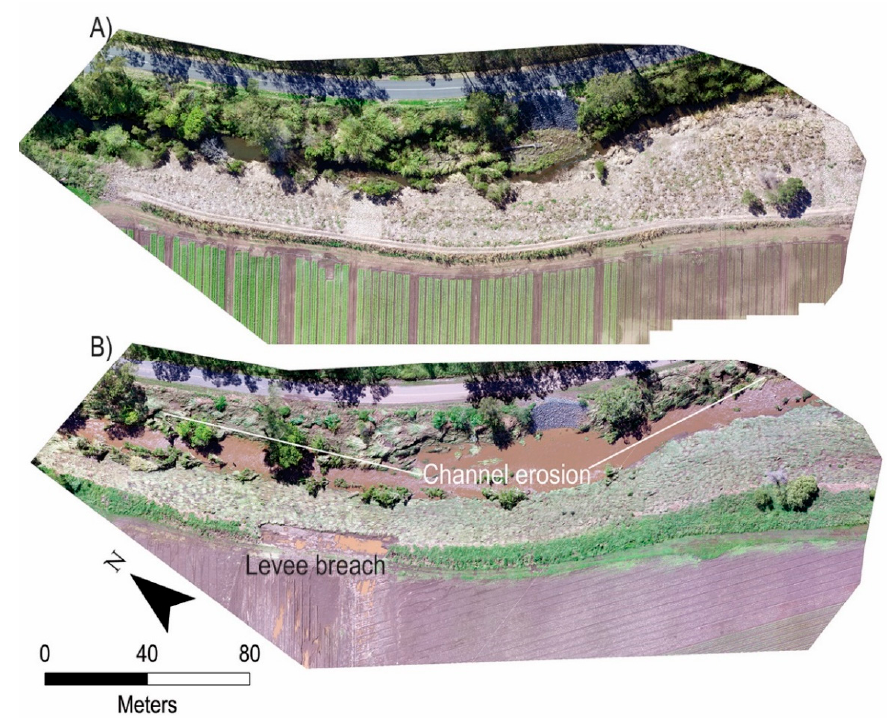
Figure 4. High-resolution mosaic imagery (pixel resolution <2 cm) of the study area collected ( A ) prior to the major flood event on 16 July 2016 and ( B ) immediately after the event, 31 March 2017, showing the widespread channel erosion on the natural bank and the levee breach on the rehabilitated bank. Oblique imagery from the site highlighted the contrast between the natural bank and the rehabilitated bank (Figure 5). Despite being on the inside bend, the natural bank experienced substantial erosion, whilst the rehabilitated bank on the outside of the bend was largely stable (Figure 5). This further highlights the potential for streambank rehabilitation to reduce sediment loading from channel erosion, a critical sediment loading source to Moreton Bay [6,11].